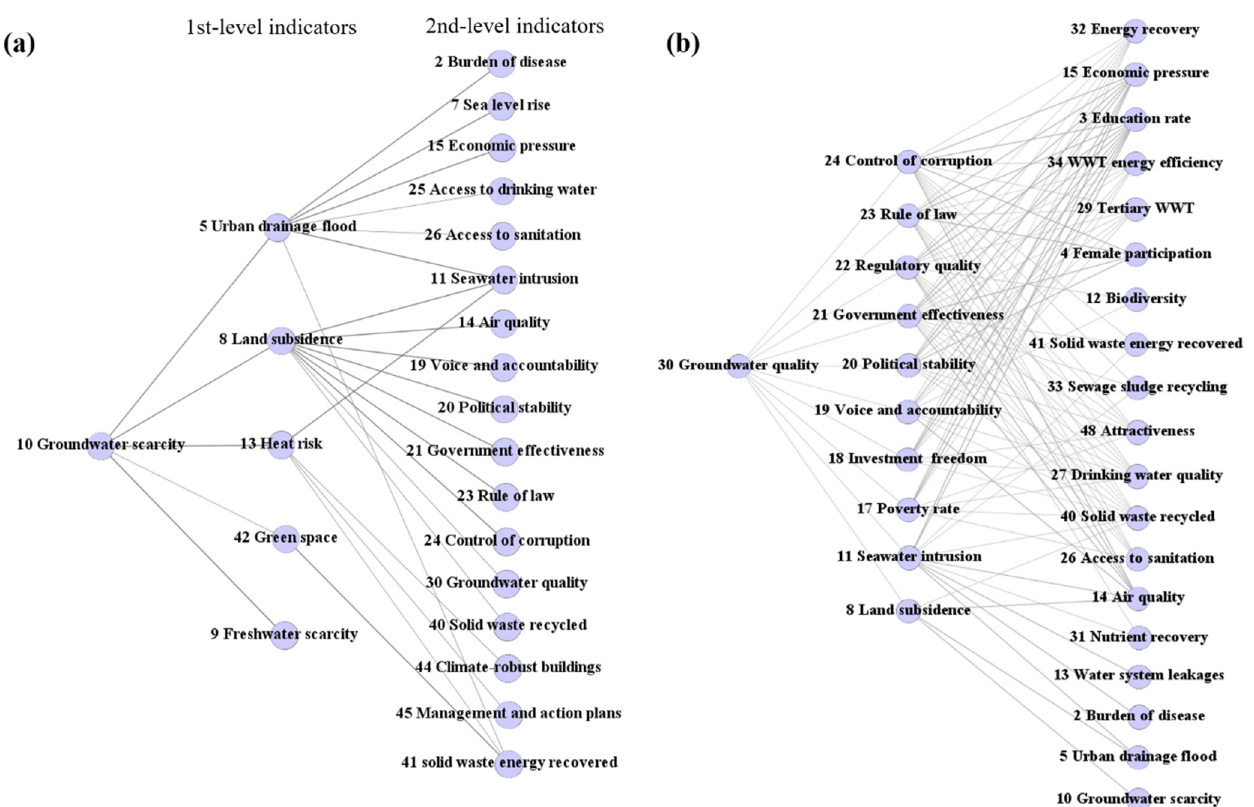
Figure 3. First and second-level indicators of groundwater scarcity ( a ) and quality ( b ). First-level indicators are connected to groundwater, and second-level indicators are connected to first-level